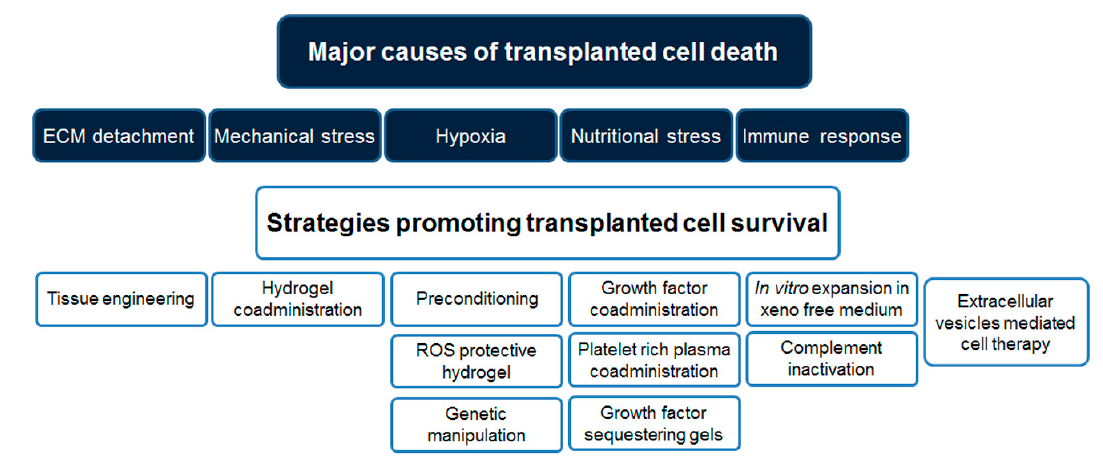
Figure 1. Schematic representation of the major factors limiting cell survival during the transplantation procedure and possible strategies to improve cell-based therapies. Abbreviations: ECM: extracellular matrix; ROS: reactive oxygen species.